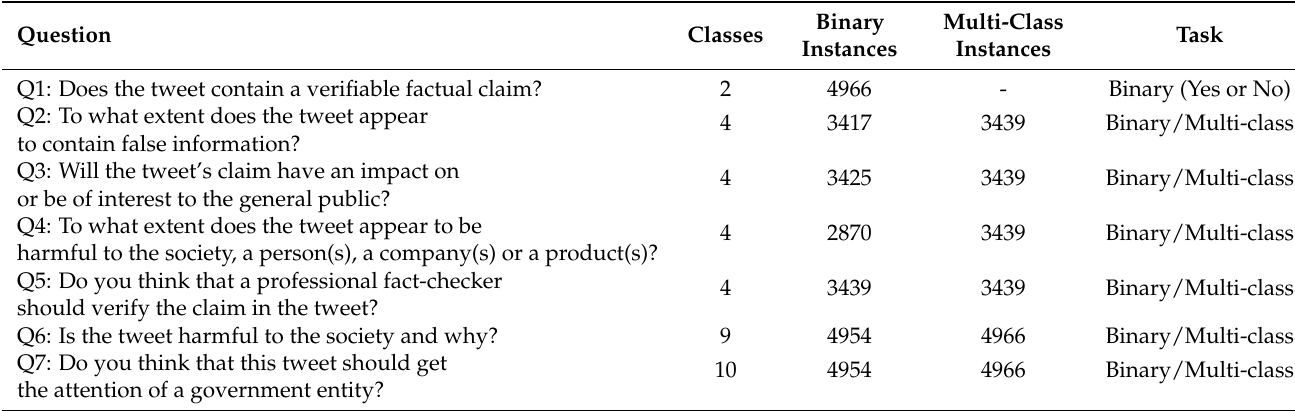
Table 1. The main datasets’ descriptions and their corresponding samples.